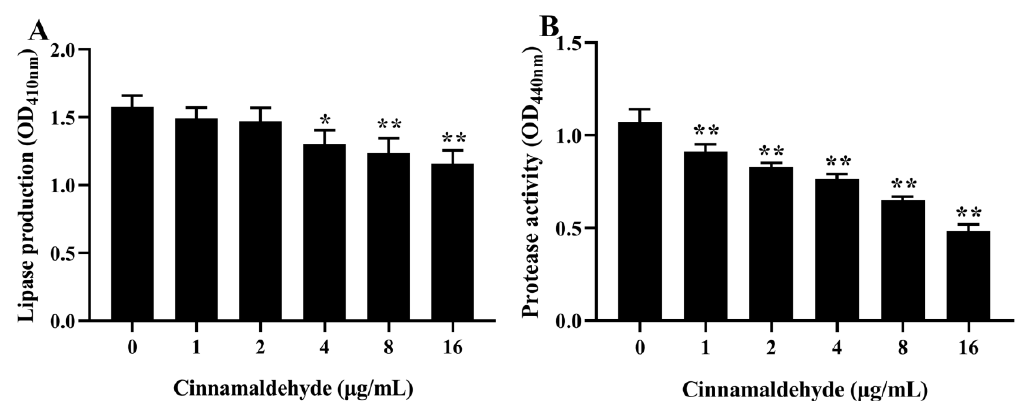
Figure 2. Inhibitory effect of cinnamaldehyde on two extracellular enzymes of A. hydrophila . ( A ) Lipase production of A. hydrophila plus cinnamaldehyde; ( B ) the effect of cinnamaldehyde on the protease activity of A. hydrophila . The data in both assays are mean ± SD of three independent experiments. *, 0.01 < p < 0.05 and **, p < 0.01 when compared with drug-free group.